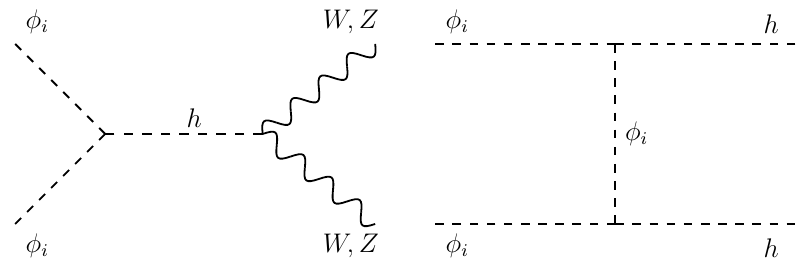
Figure 1 . Dark matter φ i annihilation processes involving the λ Si interactions. These processes are common to both Z 4 and Z 6